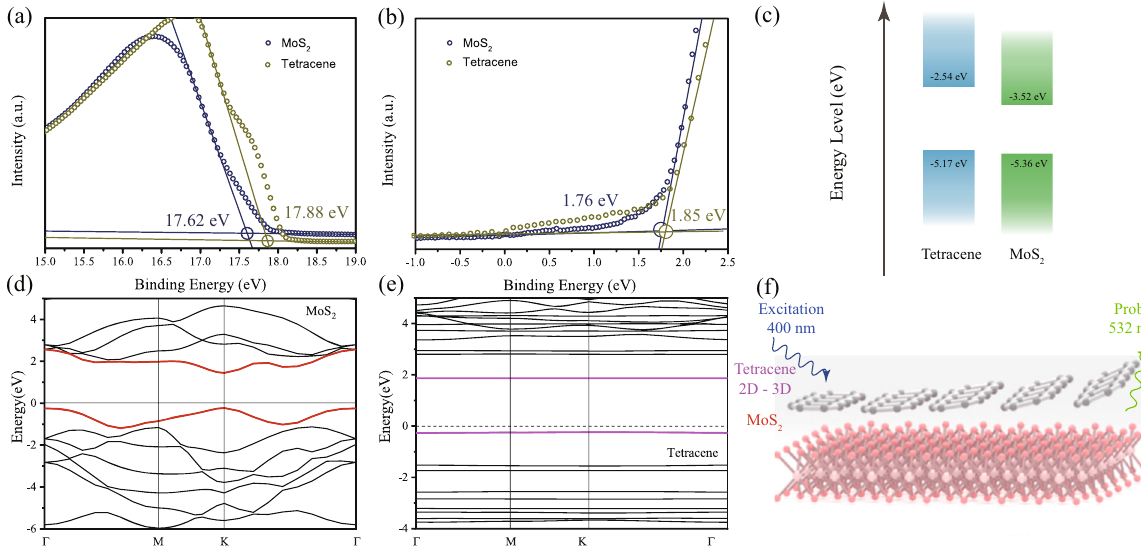
Fig. 1 Energy level arrangement and schematic image of O-I heterojunction. a UPS spectra of the secondary electron edge for monolayer MoS 2 and top organic layer tetracene. The extracted work functions for both structures are indicated, which are 3.58 and 3.32 eV, respectively. The work function was obtained by the equation: ω ¼ hv (cid:2) E cut (cid:2) off . b UPS spectra at the low binding energy region near the Fermi level for monolayer MoS 2 and top organic layer tetracene. c The constructed band diagram of the tetracene/MoS 2 organic-inorganic vdW heterojunction. d – e The fi rst principle DFT calculations of MoS 2 and tetracene, respectively. The calculation results con fi rmed that the tetracene/MoS 2 organic-inorganic heterostructure was Type-II band alignment. f Schematic con fi guration of tetracene/MoS 2 O-I vdW